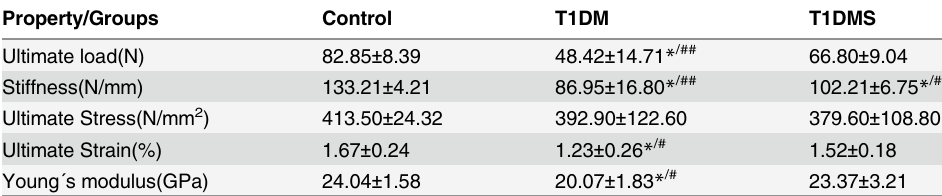
Table 2. Tibia biomechanical parameters of control, diabetic, and diabetic plus zinc supplementation groups.